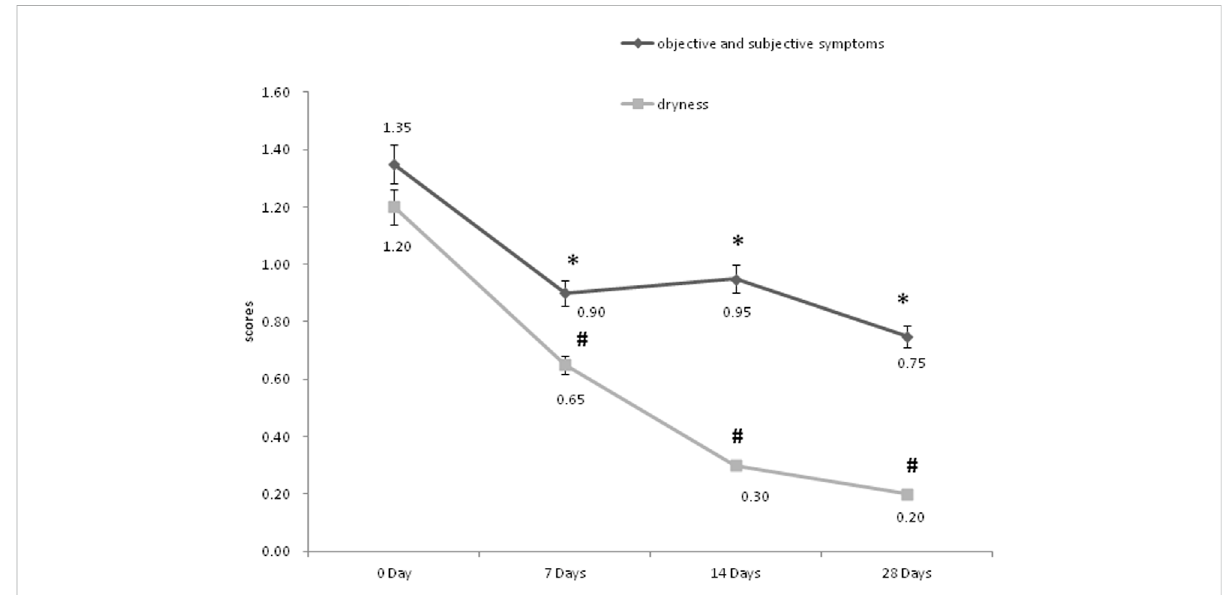
FIGURE 5 The objective, subjective symptoms and dryness assessment of the dermatologist. * p < 0.05, scores of objective and subjective symptoms, compared to the baseline (0 Day). # p < 0.05, scores of dryness, compared to the baseline (0 Day).